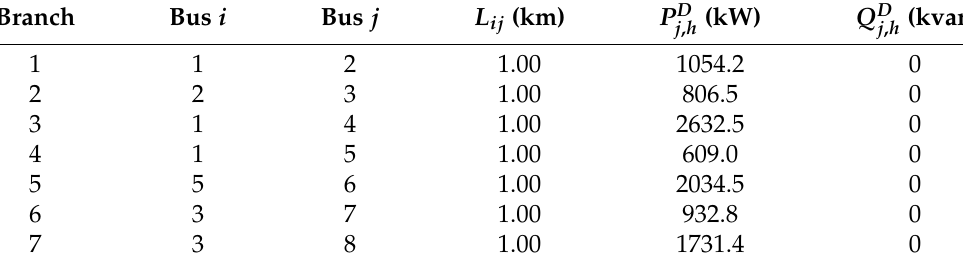
Table 6. Parametric information of the 8-bus test feeder for the balanced case.